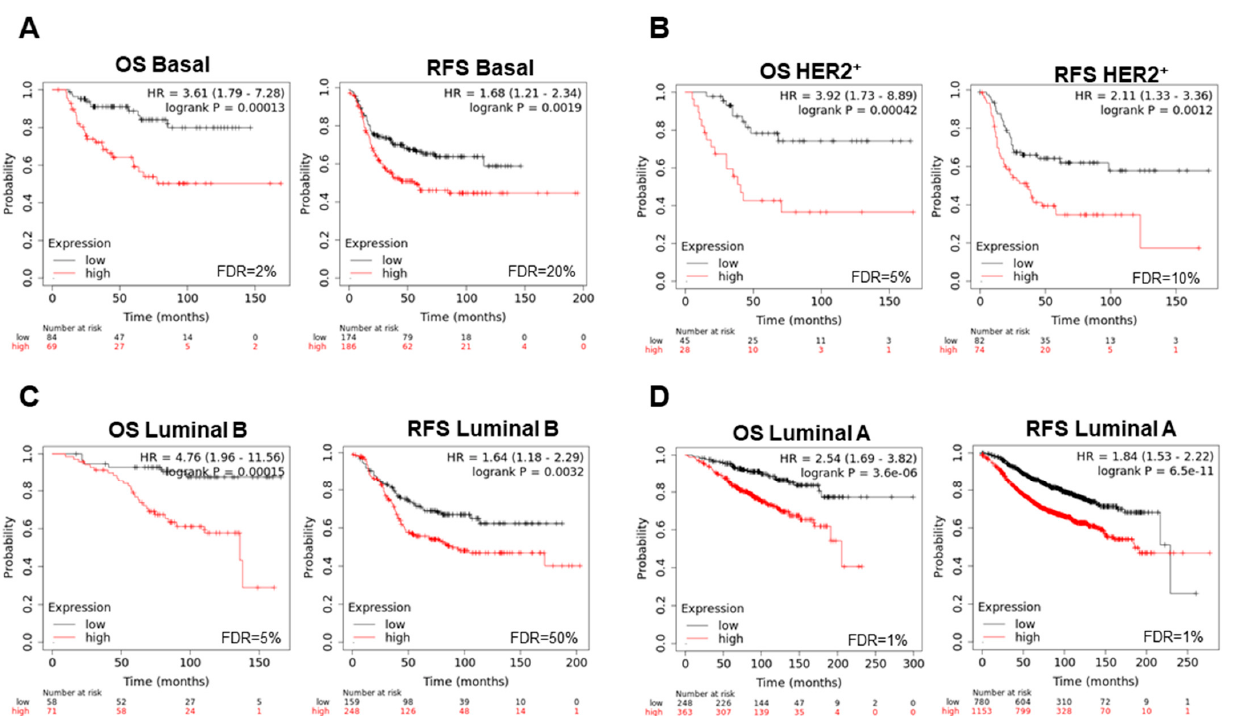
Figure 6. Best signature of DNA damage response genes to indicate poor survival in each breast cancer subtype. ( A ) Association with OS and RFS of gene sets in basal-like ( CSTF1, RAD1 , and YWHAB ), ( B ) HER2+ ( FANCD2, MCM7, YWHAB, and BHLHE40 ), ( C ) luminal B ( BRIP1, CDC6, CSTF1, NBN, PRKDC, RFC4, RFWD2, UBE2T, YWHAB , and YWHAZ ), and ( D ) luminal A ( CCNE1, FANCI, RFC4, CDC6 , and YWHAZ